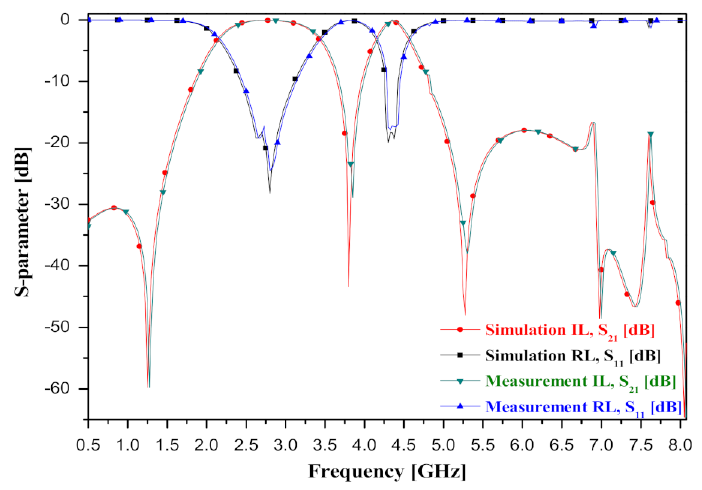
Figure 5. Experimental results for proposed BPF.